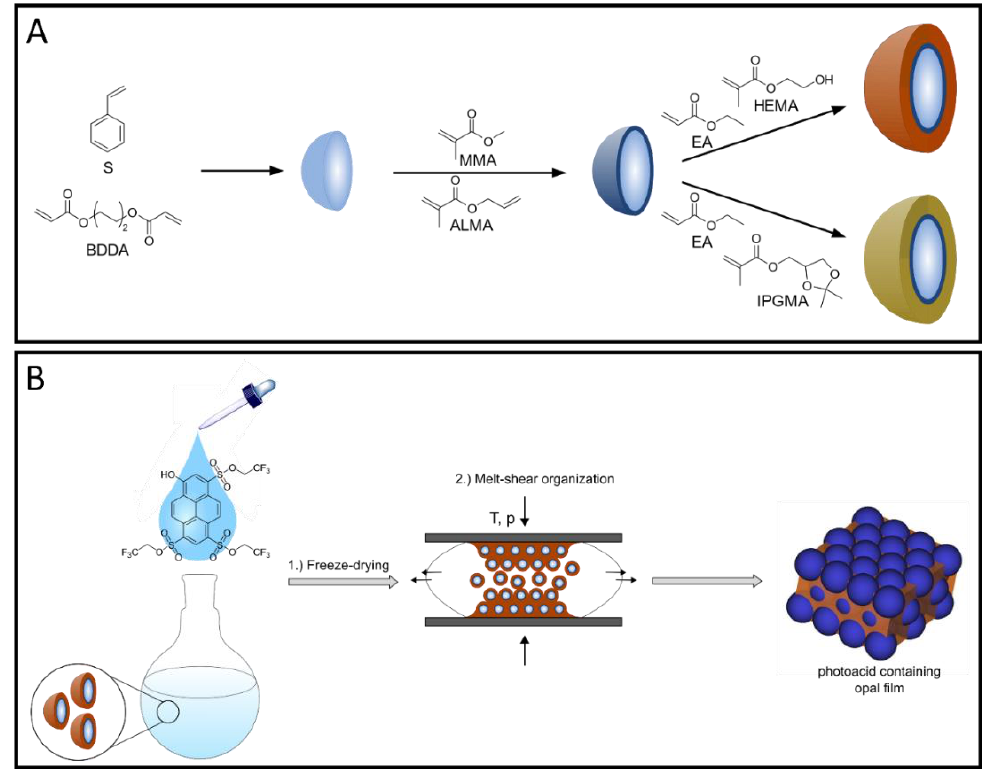
Figure 1. ( A ): Schematic representation of the synthesis of hard core poly(styrene- co -butanediol diacrylate) (P(S- co -BDDA)) and soft shell poly(ethyl acrylate- co -2-(hydroxyethyl) methacrylate) ((P(EA- co -HEMA)) or poly(ethyl acrylate- co -isopropylideneglycerol methacrylate) (P(EA- co -IPGMA))) particles by semi-continuous emulsion polymerization. The interlayer consists of poly(methyl methacrylate- co -allyl methacrylate) (P(MMA- co -ALMA)). ( B ): Incorporation of the photoacid (tris(2,2,2-trifluoroethyl) 8-hydroxypyrene-1,3,6-trisulfonate (TFEHTS)) and subsequent opal film preparation using the melt-shear organization